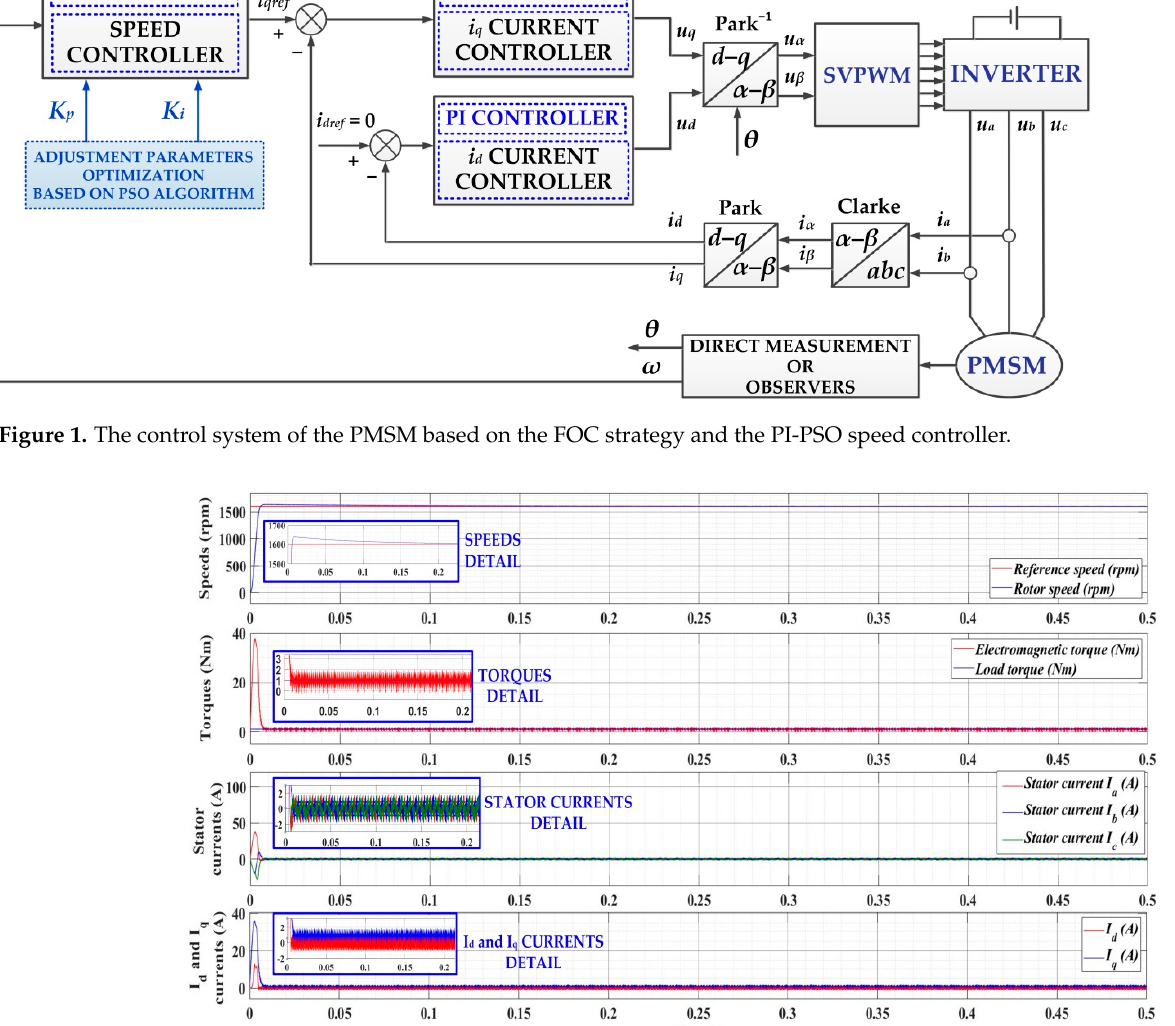
Figure 2. Time evolution for the numerical simulation of the PMSM control system based on the PI